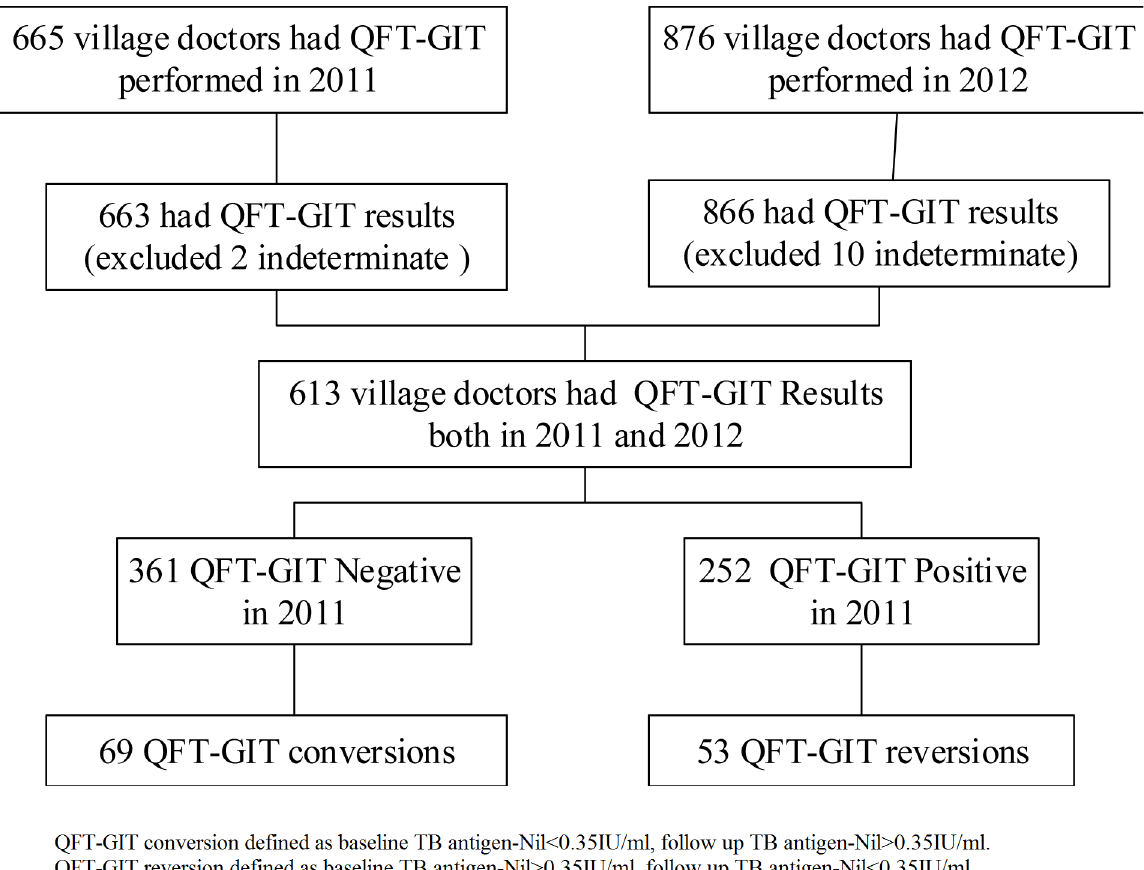
Fig 1. The QFT-GIT results of a baseline cross-sectional survey in December 2011 and the follow-up survey in December 2012 of village doctors in two counties in the Inner Mongolia Autonomous Region, China.